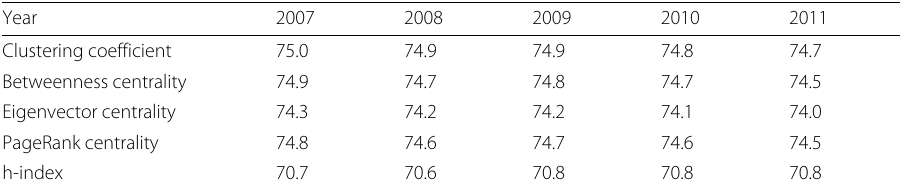
Table 4 Percentage of change points in terms of increasing/decreasing trend in node position sequence of a referral